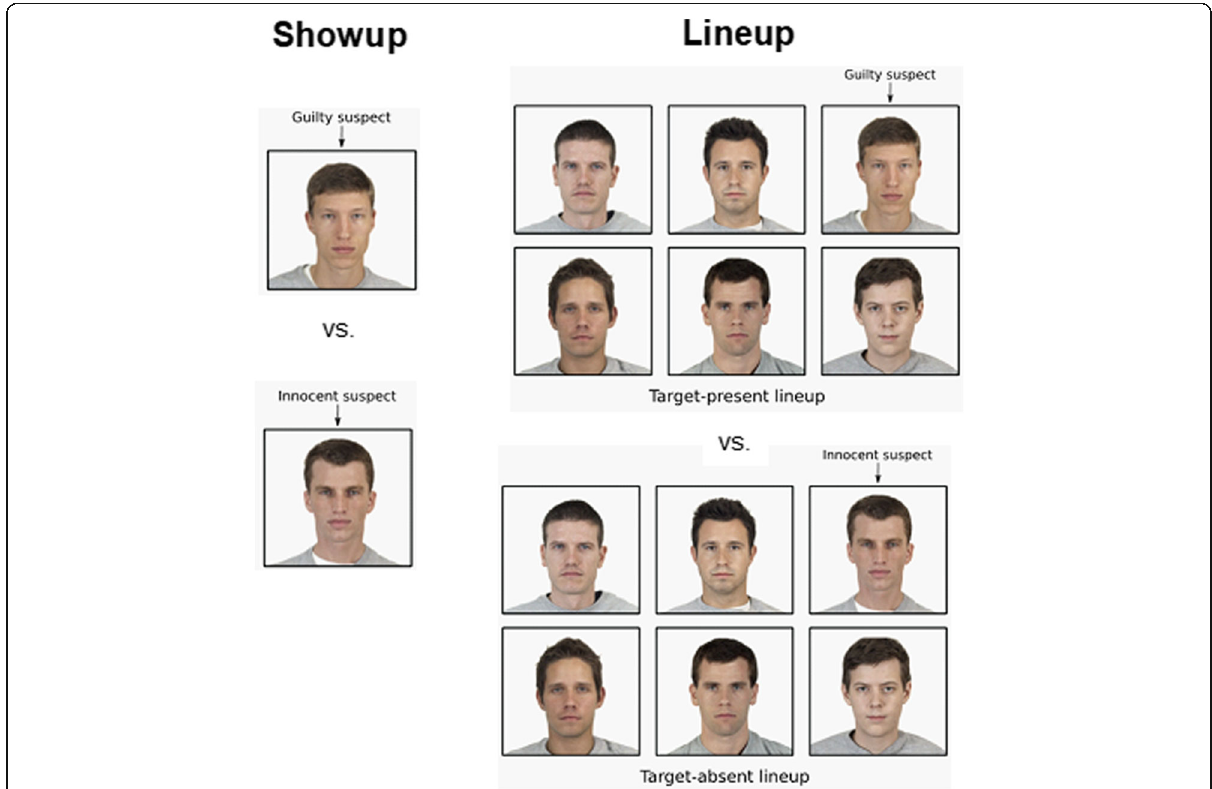
Fig. 1 An illustration of two common eyewitness identification procedures. The left panel illustrates a showup in which the recognition memory test consists of a single photo – either the guilty suspect (the target) or an innocent suspect (the foil) – presented for a yes/no decision. The right panel illustrates a simultaneous lineup in which the recognition memory test consists of the presentation of a target-present array containing one guilty suspect (the target) and five fillers (foils) or a target-absent array containing one innocent suspect and five fillers (all foils). Suspect faces and filler faces from the Chicago Face database (Ma, Correll, & Wittenbrink,